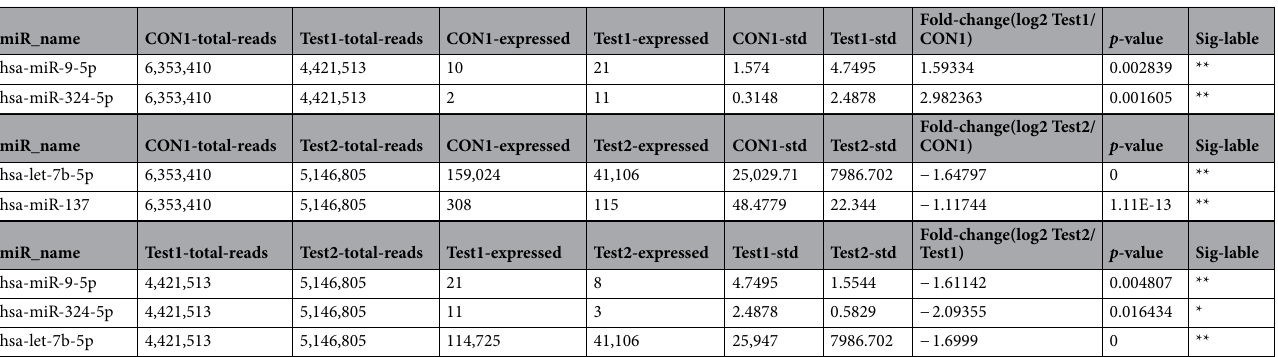
Table 6. Differential expression in candid conserved microRNAs between Control, Test 1 (RA + /Shh +) and Test 2 (RA-/Shh-) groups. The analysis of miRNA sequencing revealed a significant up-regulation of mir- 9-5p and mir-324-5p in Test 1 (RA + /Shh +); and down- regulation of mir-137 and let-7b in Test 2 (RA-/Shh-) when the results were compared with the